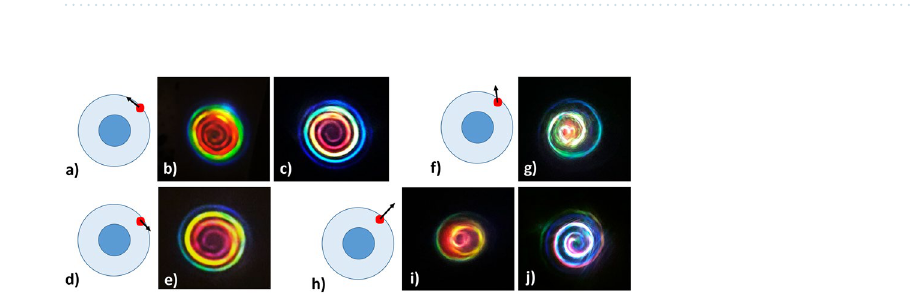
Figure 5. ( a ) Rainbow spiral simulation as a sum of the single color components. In all images, we only display points with intensities larger than two thirds of the peak value. ( b , c ) Fibre output spectra at different input peak powers (up to 48 MW) at 1030 nm in step- and graded-index fibres, respectively, keeping the same coupling conditions. ( d ) Far-field image of graded-index fibre when varying the input beam position while keeping the peak power at 48 MW, with ϑ = 1.5 ◦ and ϕ = 45 ◦ . ( e ) Ray optics sketch of conical emission analogy. On the top, the SC is generated inside the fibre volume. On the bottom, the SC generates at the air–cladding interface.